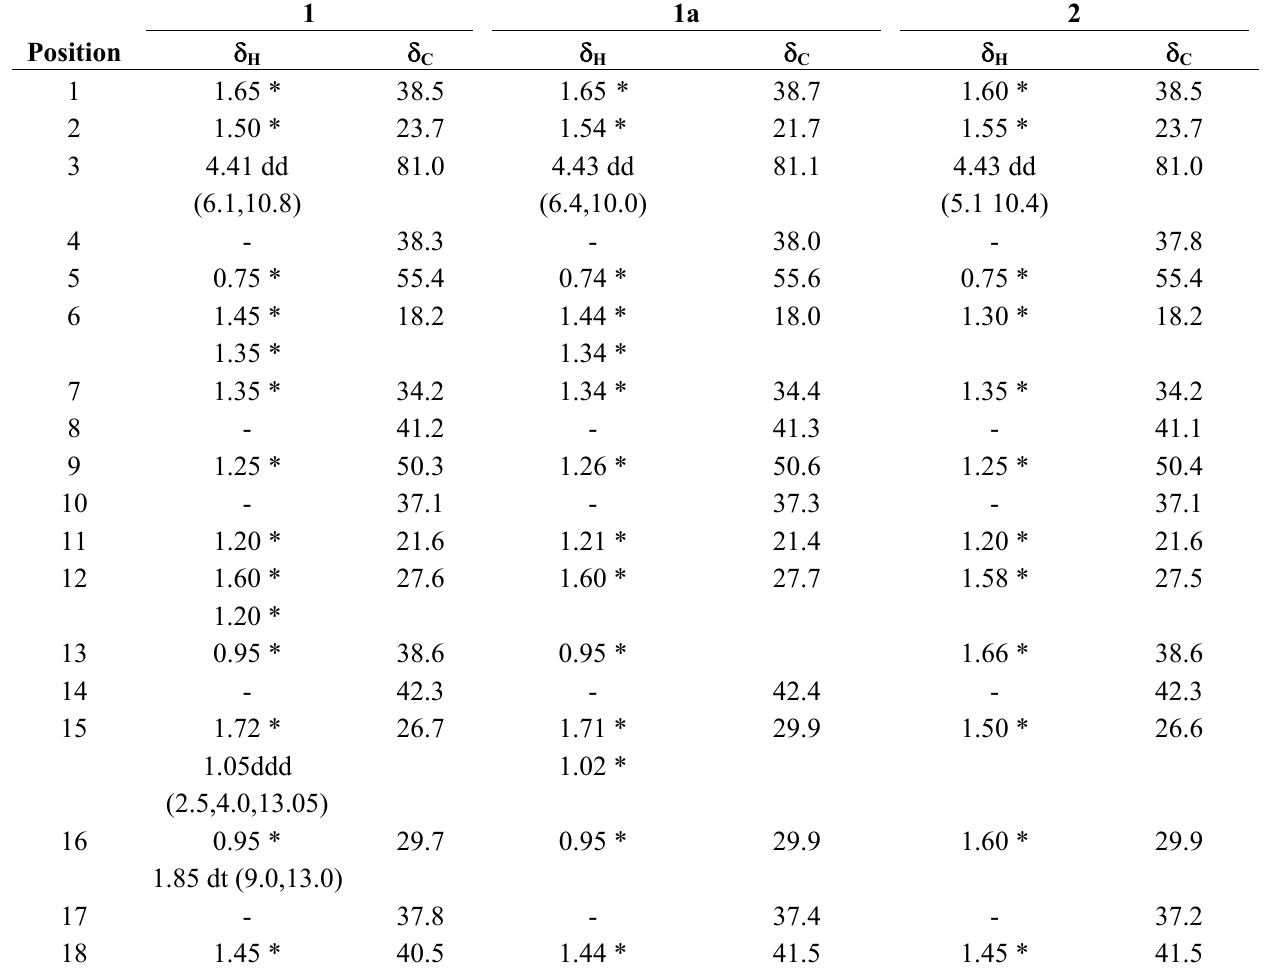
Table 1. 1 H- and 13 C-NMR data for compounds 1 , 1a and 2 a